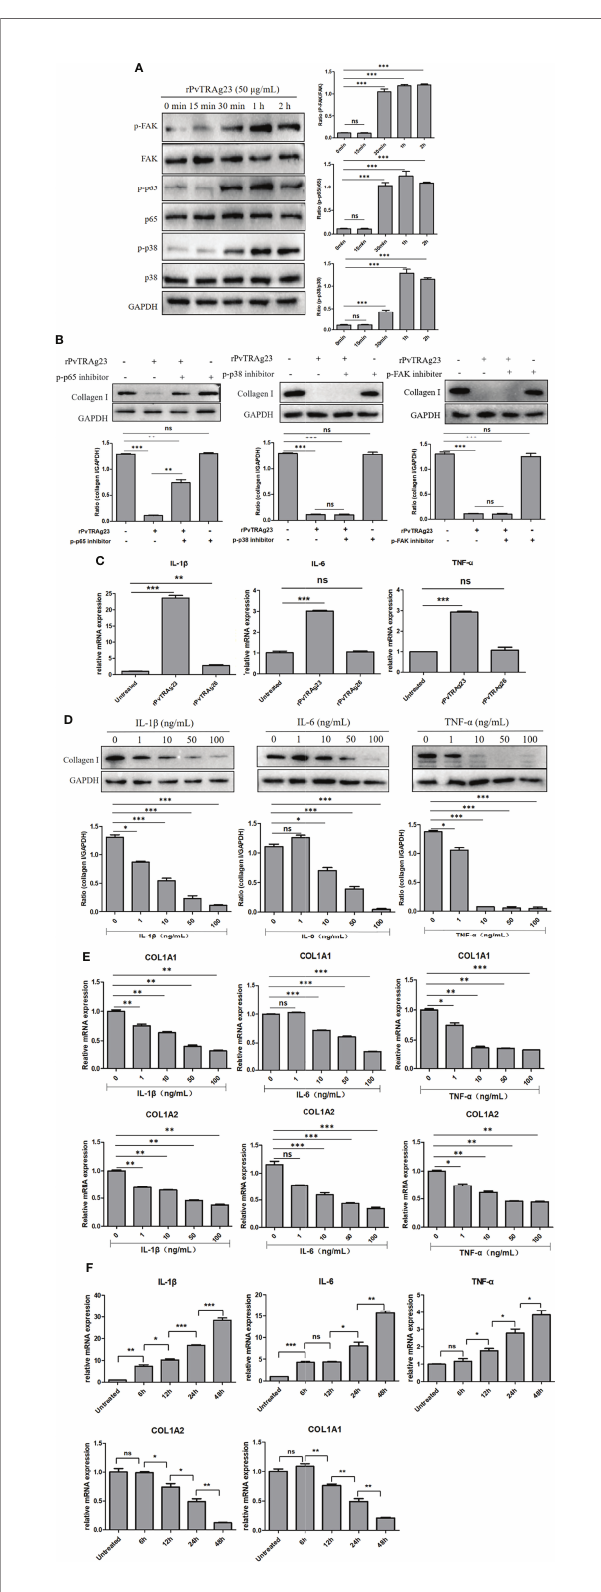
FIGURE 4 | NF- k Bp65 mediates increased expression of IL-1 b , IL-6, and TNF- a to decrease collagen I in HSF. (A) 5 × 10 6 HSFs were stimulated with 50 m g/mL rPvTRAg23 for corresponding time, the treated cells were collected and the corresponding signaling pathway antibodies were incubated respectively. The pathway activation status of each group was detected by western blot (left) and quanti fi ed by GAPDH as internal reference (right). (B) 5 × 10 6 HSFs were pretreated with corresponding signaling pathway inhibitors for 1 h, and 50 m g/mL rPvTRAg23 was used to stimulate treated and untreated cells. After 48 h, the expression of collagen I in each group was detected by western blot (up), and GAPDH was used as the internal participating group for comparison (down). Plus (+) indicates added; minus (-) indicates not added. (C) 5 × 10 6 HSFs were treated with 50 m g/mL rPvTRAg23 or rPvTRAg26 respectively, and RNA was extracted from the treated and untreated groups 48 h later. The expressions of related cytokines were detected by qPCR and compared with the control group. Three individual experiments have been performed. (D) The corresponding concentrations of commercial cytokines were used to incubate 5 × 10 6 HSFs respectively for 48 h, lysed the cells and detected the expression of collagen I in each group by western blot (up). GAPDH was used as an internal parameter for gray value comparison (down). (E) 5 × 10 6 HSFs were stimulated with the corresponding concentrations of IL-1 b , IL-6 or TNF- a respectively for 48 h, RNA was extracted from each group. The mRNA expressions of collagen I were detected by qPCR and compared with that in the untreated group. Three individual experiments have been performed. (F) 5 × 10 6 HSFs were stimulated with 50 m g/mL rPvTRAg23 for different times and the mRNA expression of each group was detected by qPCR. Three individual experiments have been performed. Statistical analyses were carried out by one-way ANOVA with Dunnett ’ s multiple comparisons test. (ns P >=0.05; *P < 0.05; ** P < 0.01; *** P <